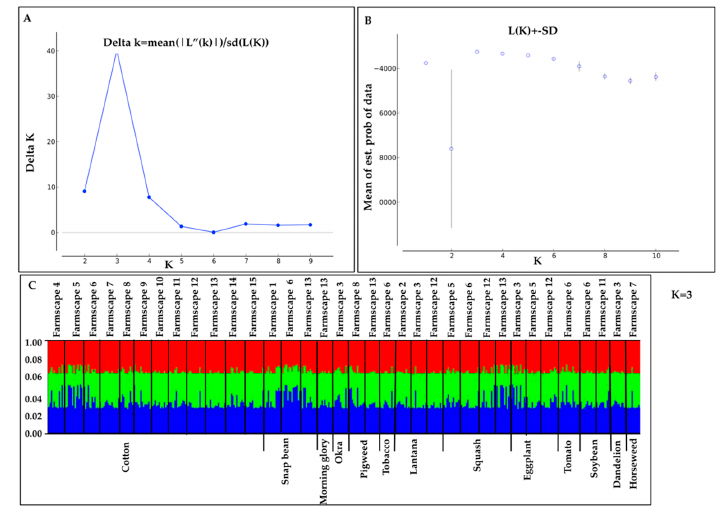
Figure 3. Bayesian clustering analysis results for 35 B. tabaci MEAM1 populations based on six microsatellite markers using STRUCTURE v.2.3.2. ( A ) Optimal number of genetic clusters ( K = 3 ) following methods described by Evanno et al. 2005. ( B ) Plot of average likelihood L(K) and variance per K. ( C ) Scatter plots at K = 3. The length of each line in the bars represents the proportion of the genome in different clusters. Whitefly populations collected from different host plants or farmscapes are separated by a continuous vertical black line.